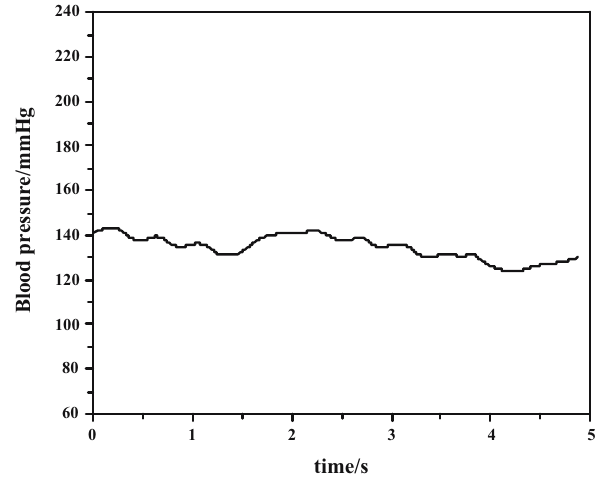
Figure 5: Blood pressure value